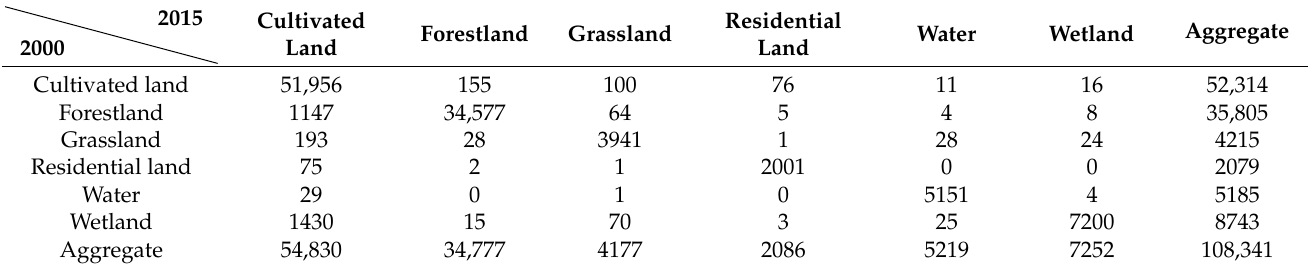
Figure 5. Spatial variation of land use type. Table 3. Transfer matrix of land use type. (Unit: km 2 ).